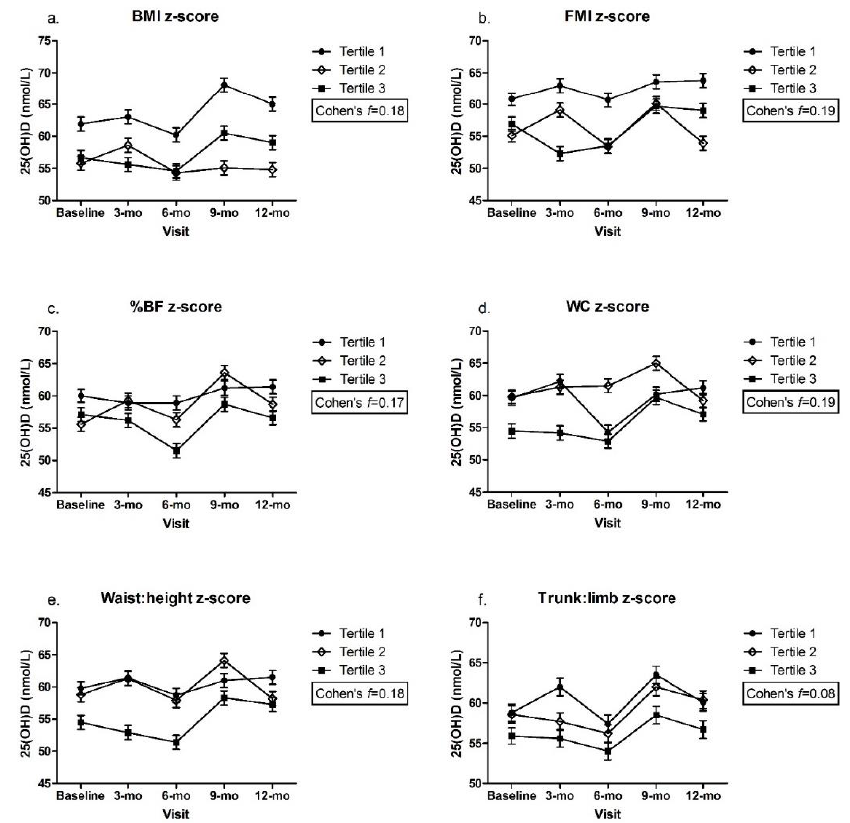
Figure 1. ( a ). BMI z-score; ( b ). FMI z-score; ( c ). %BF z-score; ( d ). WC z-score; ( e ). Waist:height z-score; ( f ). Trunk:limb z-score. Plasma 25(OH)D across adiposity indicator (z-scores) by visit. Mixed effects model, mean ± SEM. Covariates include UVB exposure period, constitutive skin color, sunscreen use, dietary vitamin D intake. Values with same superscripts are significantly different from each other; p < 0.05, n = 101. Effect size reported as Cohen’s f . Abbreviations: 25(OH)D = 25-hydroxyvitamin D; Android:gynoid = android – gynoid ratio; BF = body fat; BMI = body mass index; FMI = fat mass index; height:weight = height-to-weight ratio; LMI = lean mass index; trunk:limb = trunk-to-limb ratio; waist:height = waist-to-height ratio; WC = waist circumference.